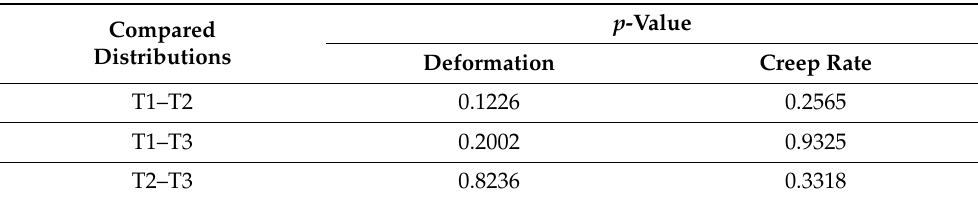
Table 5. p -values from two-sample t -test comparing triaxial cyclic compression test results at different temperatures.